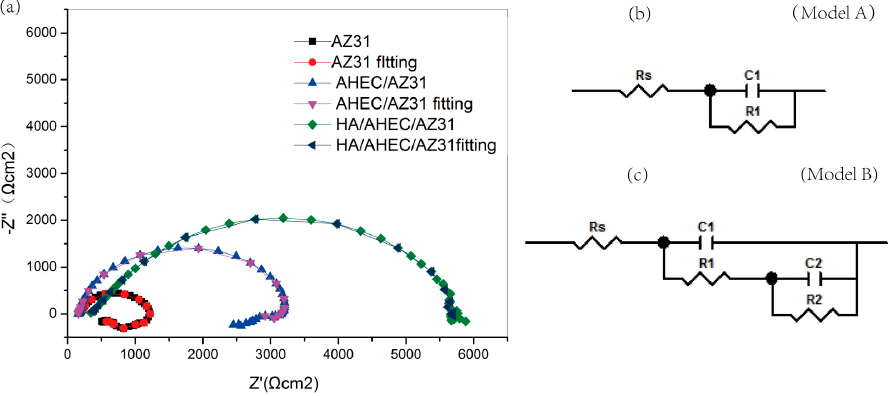
Figure 5. ( a ) Nyquist curve; and ( b , c ) the equivalent circuit of all samples soaked in SBF.